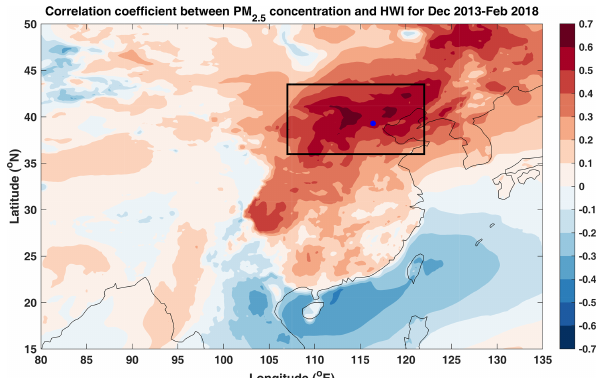
Figure 4. Spatial distribution of the correlation between winter PM 2 . 5 concentration and HWI time series at each grid point. Blue dot shows the Beijing station (39.3 ◦ N, 116.4 ◦ E) and the black rect- angle shows the North China Plain (36–43.5 ◦ N, 107–122 ◦